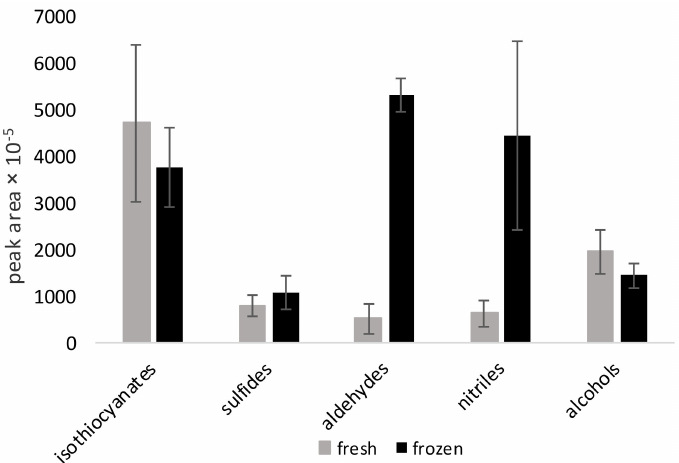
Figure 5. Mean values from all Brussels sprout cultivars (Ajax, Marte, Maximus, Neptuno and Profitus) for total peak areas of the main groups in raw non-frozen and frozen-thawed vegetables. The results are the mean of three replicates for each cultivar (i.e., 15 analyses), error bars show standard deviation. Amounts were expressed in total (sum of) peak